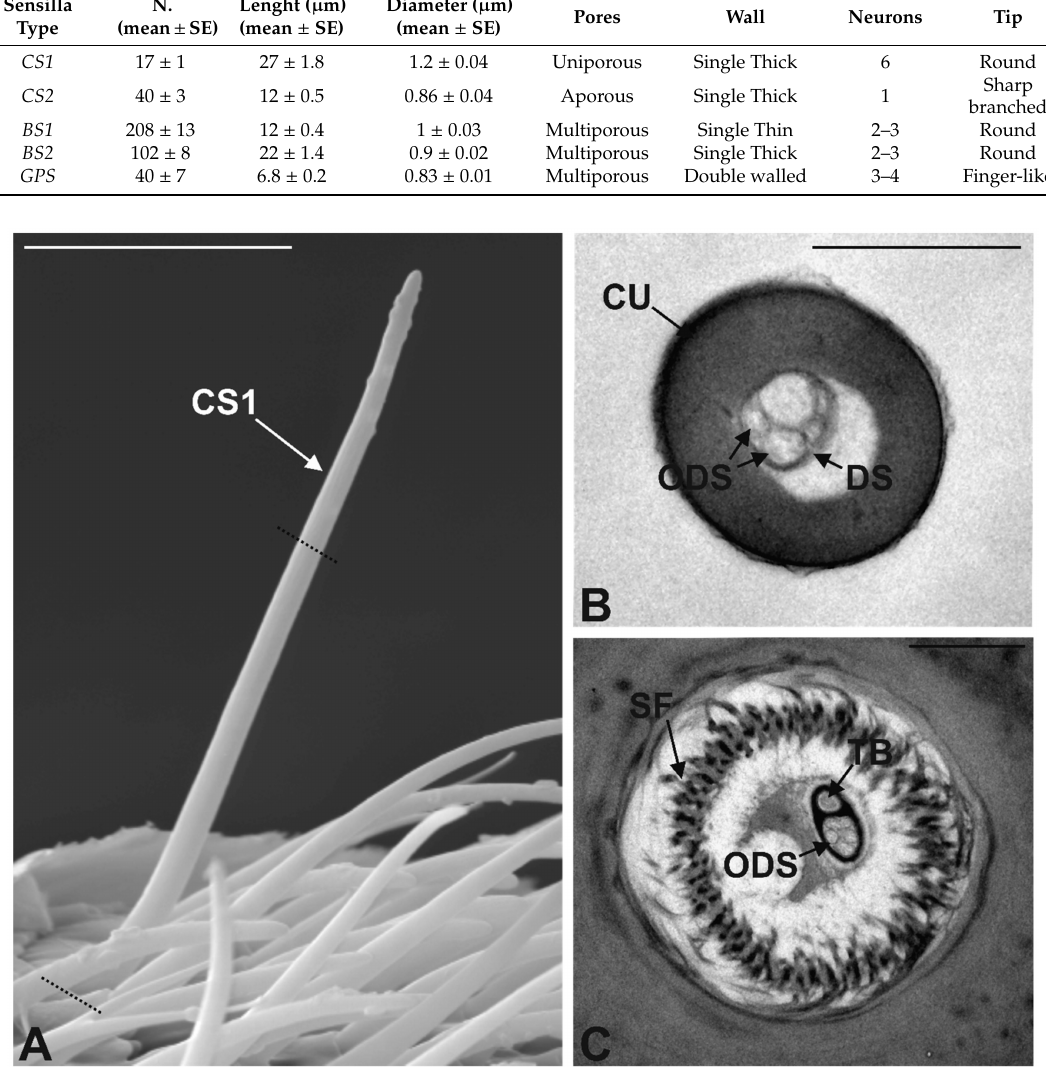
Figure 3. Chaetic Sensilla Type 1 (CS1). ( A ) SEM micrograph showing an CS1 sticking out from the rest of the antennal sensilla. Dotted lines represent the section planes showed in Figure 3B,C, respectively. ( B ) Transmission electron microscopy (TEM) cross section of CS1, the cuticle (CU) appears thick, the internal lumen is partly occupied by five outer dendritic segments (ODS) enveloped by a dendrite sheath (DS). ( C ) TEM section taken at the socket level, showing the large socket rich in suspension fibers (SF) and the outer dendritic segments (ODS) grouped by the dendrite sheath into two separated spaces, one occupied by five neurons and the other by a single neuron ending in a tubular body (TB). Bar scale: ( A ) 10 µ m; ( B ) 0.1 µ m; ( C ) 1 µ